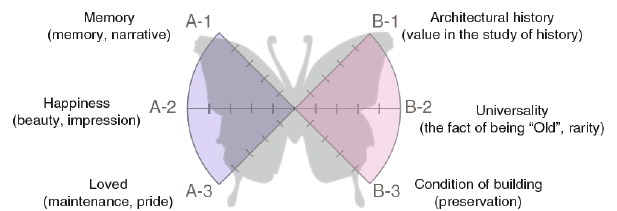
Figure 5. The 6 factors imagined in a butterfly